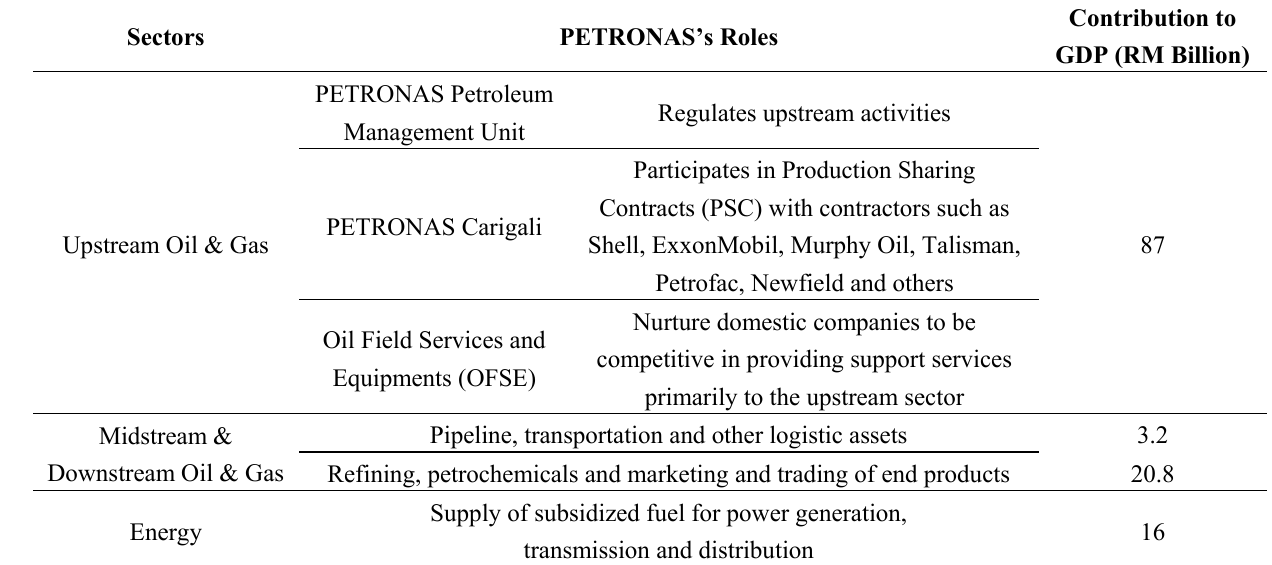
Table 1. Summary of some of PETRONAS’s key roles in the oil, gas and energy landscape in